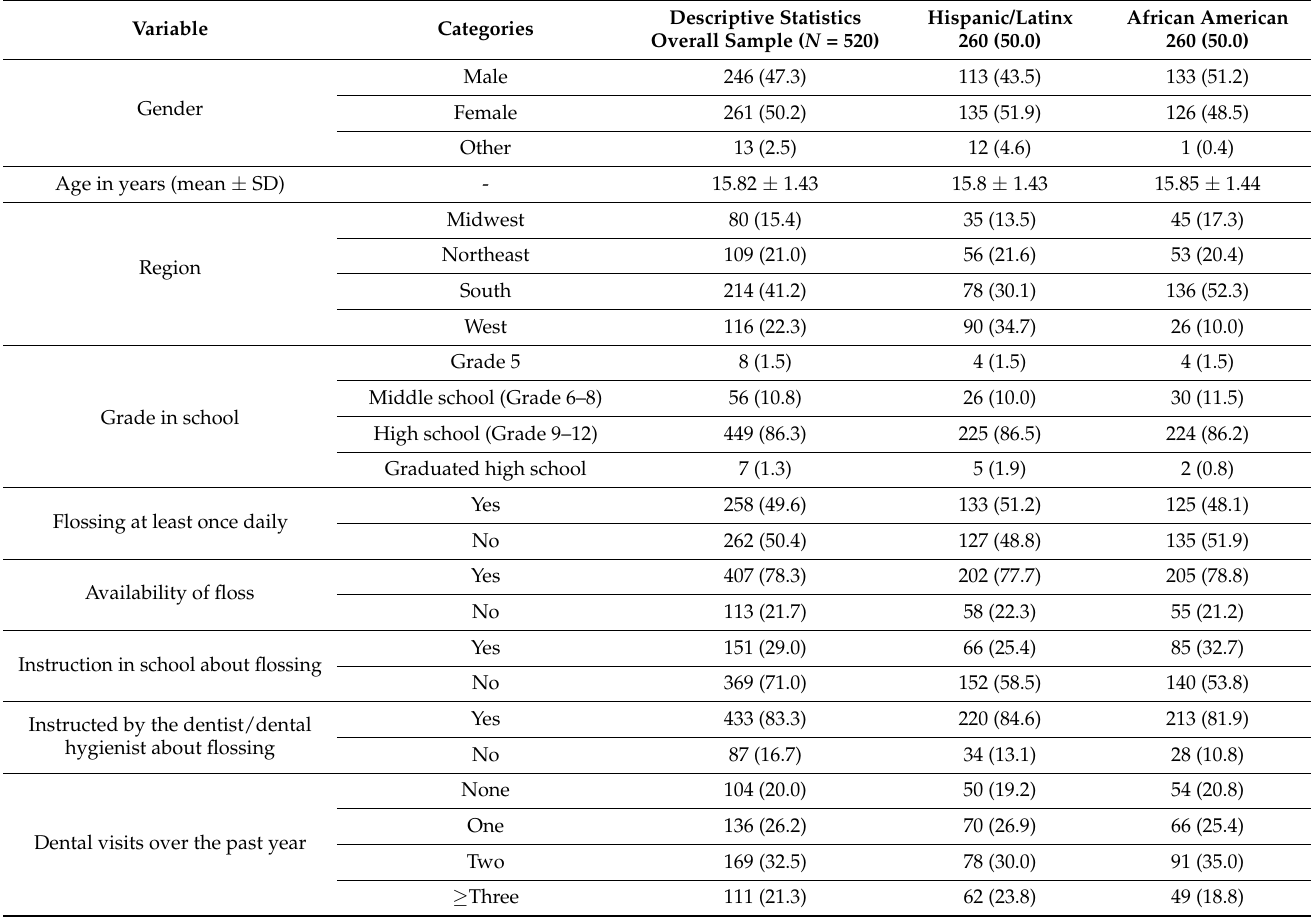
Table 4. Characteristics of the minority adolescents who participated in the study ( N = 520).